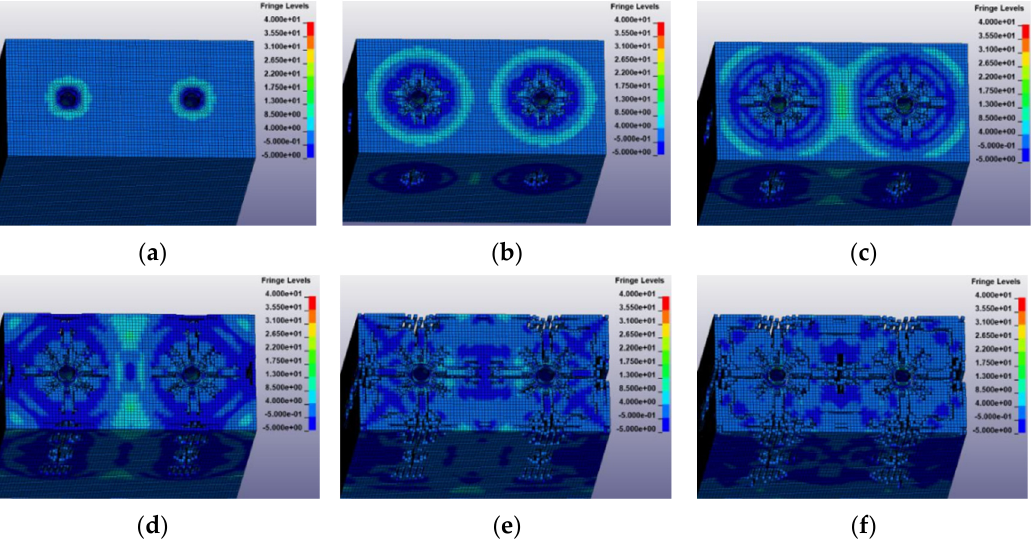
Figure 1. The simulation results of the concrete beam. ( a ) t = 55 μ s; ( b ) t = 75 μ s; ( c ) t = 85 μ s; ( d ) t = 95 μ s; ( e ) t = 120 μ s; ( f ) t = 160 μ s.